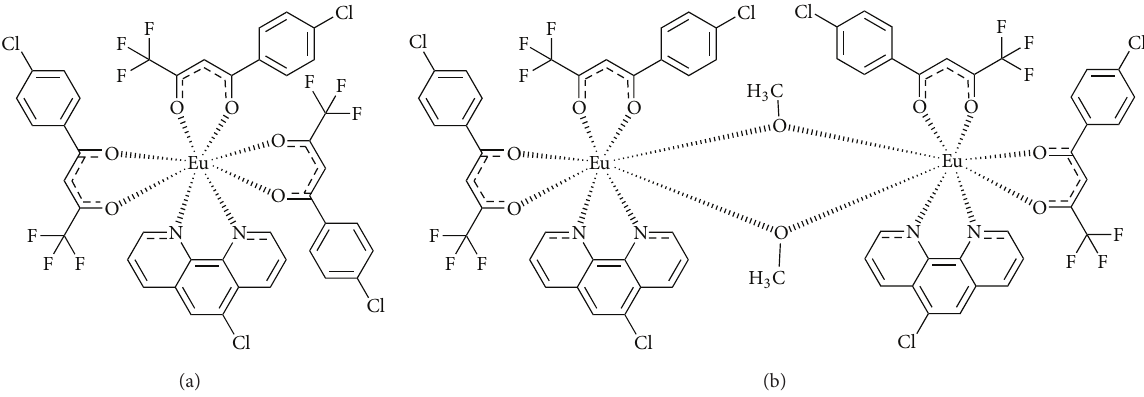
Figure 1: Chemical structures of complex 1 (a) and complex 2